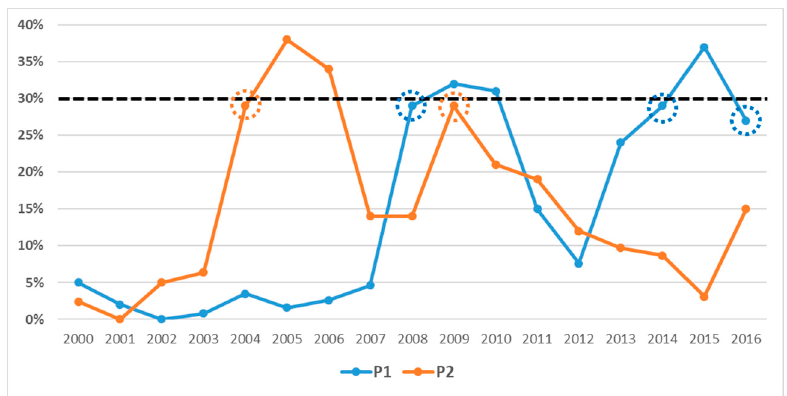
Figure 4. Temporal trends of the recurrence percentages computed for two pixels, P1 and P2, selected within the ROI (see Figure 1).